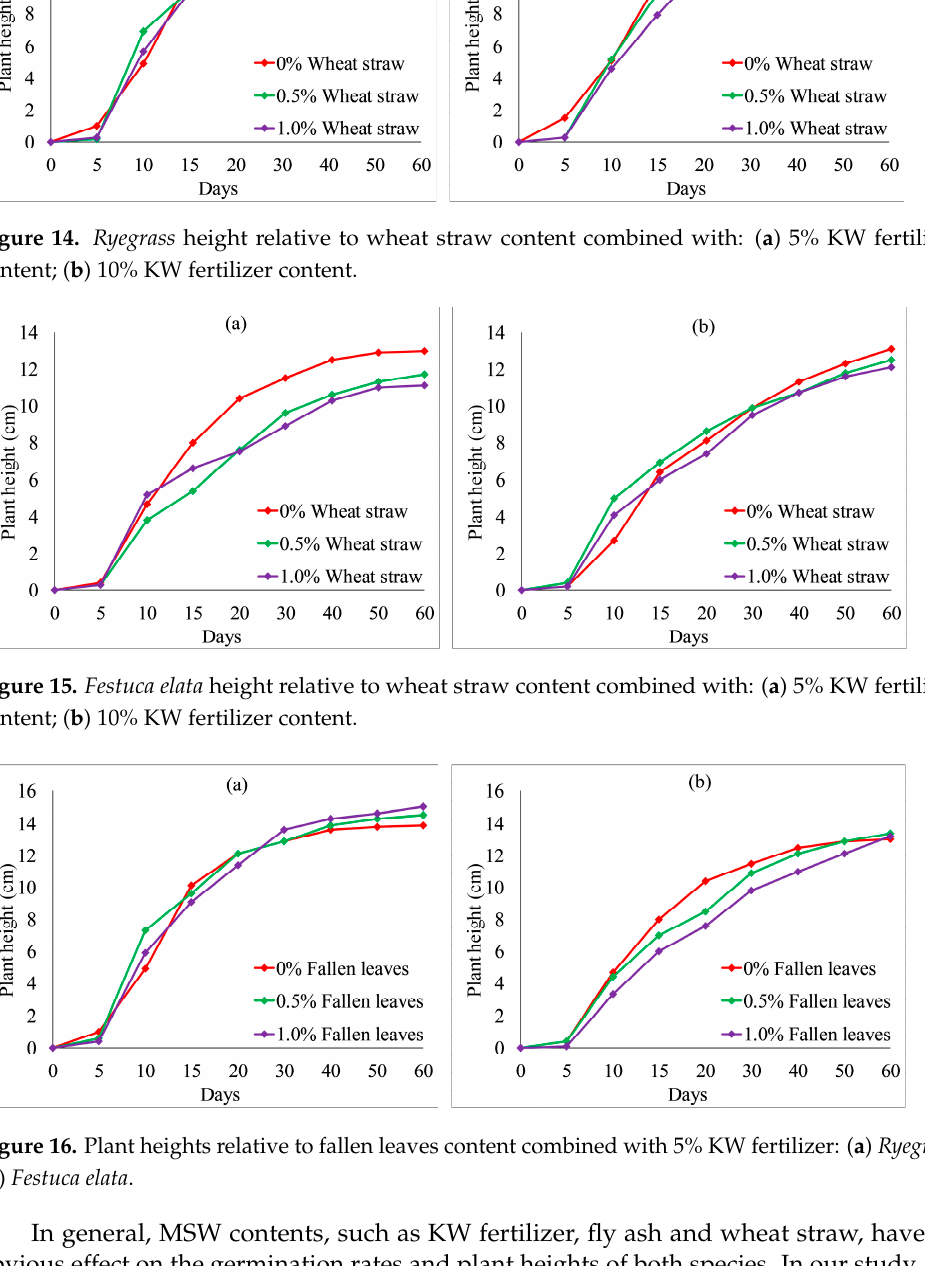
Figure 16. Plant heights relative to fallen leaves content combined with 5% KW fertilizer: ( a ) Ryegrass ; ( b ) Festuca elata .